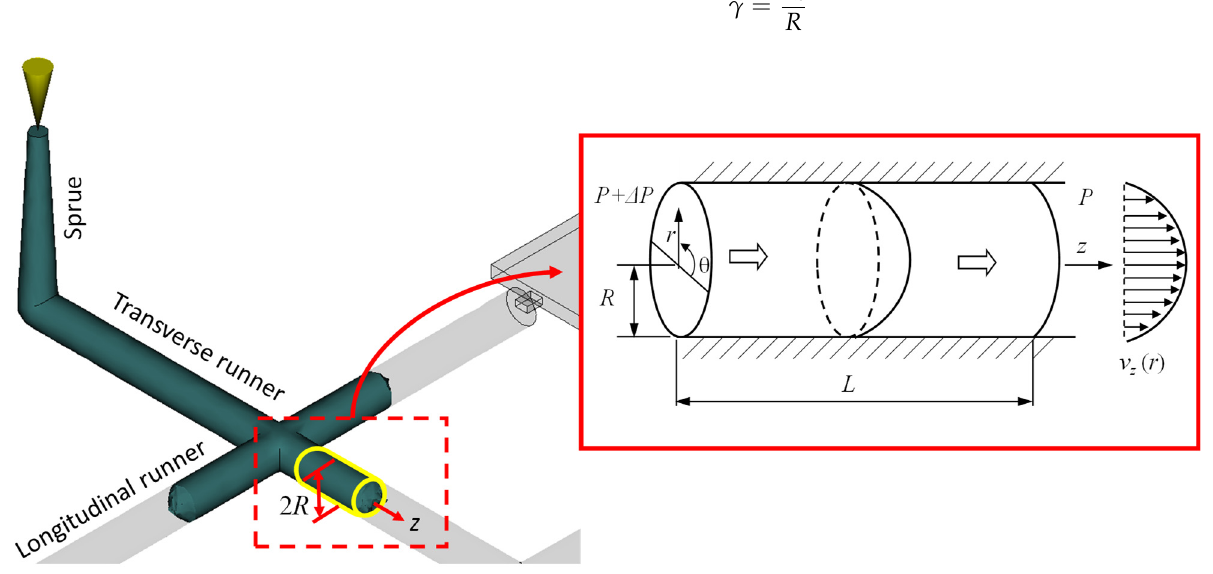
Figure 1. The flow behavior of the molten plastic in the circular runner.